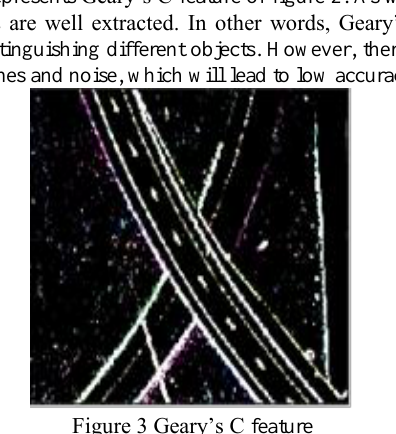
Figure 4 represents the data field feature of figure 3. It is obvious that data field method can filter and limit the noise effectively.